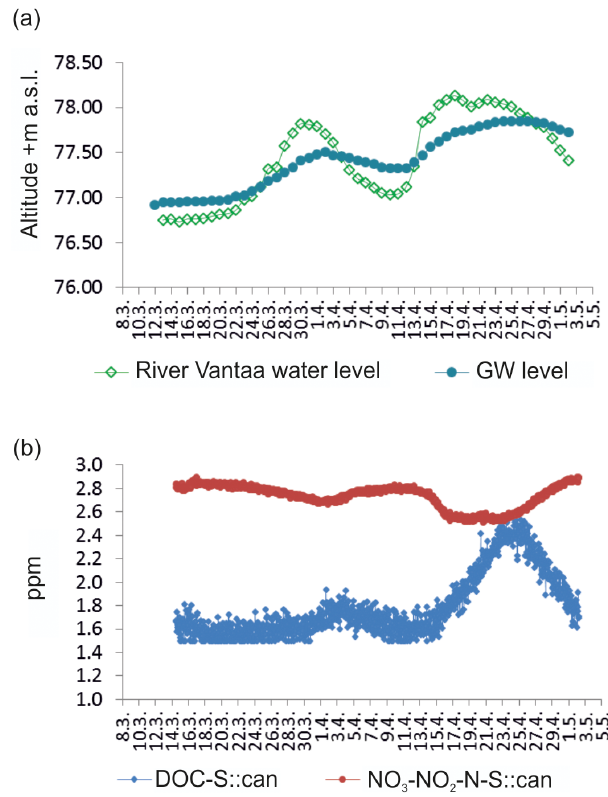
Figure 8. (a) The GW and RW level variations and (b) the DOC and NO 3 -NO 2 -N concentrations during the water quality monitoring in Hyvinkäänkylä study site from 12 March to 2 May